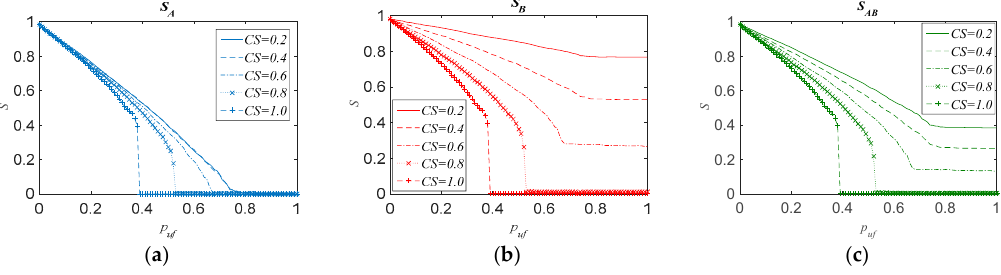
Figure 2. Simulation results of cascading failure of no-feedback interdependent networks with different coupling strength ( CS ) under unilateral failure (UF), results of one simulation. ( a )cascading failure of subnetwork A with different CS under UF; ( b ) cascading failure of subnetwork B with different CS under UF; ( c ) cascading failure of the entire interdependent networks with different CS under UF.